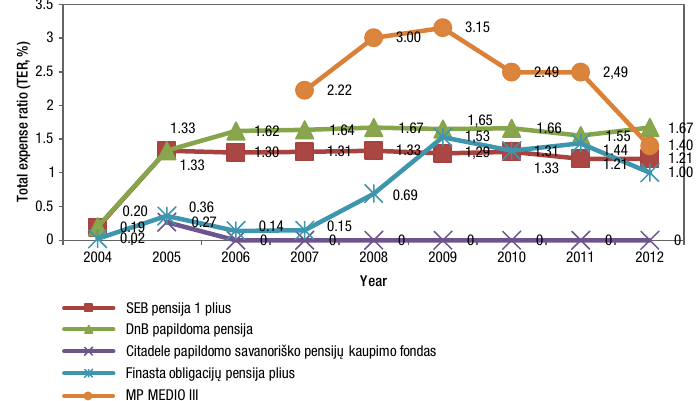
Fig. 6. Change of bond and balanced 3 rd pillar PF total expense ratio during 2004–2012 Source : created by authors according to annual reports of